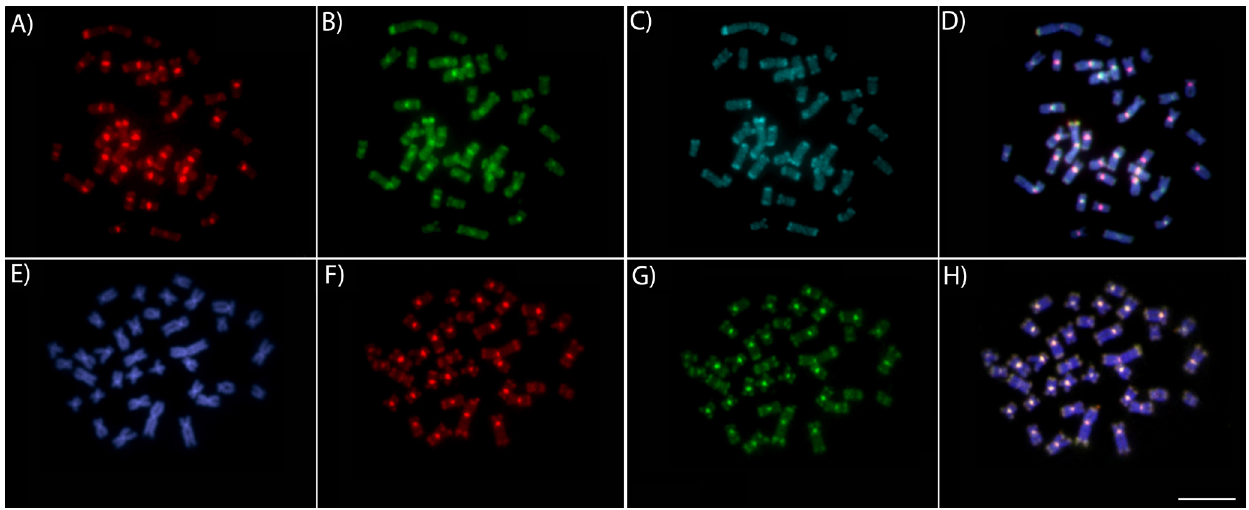
FIGURE 5 | First Row: Mitotic chromosome spreads of Lebiasina minuta males after CGH— interspecific comparisons ( A – D ). Male-derived genomic probe of L. minuta ( A ); L. melanoguttata ( B ); L. bimaculata ( C ) hybridized against male metaphase plates of L. minuta ( D ). Second Row: Mitotic chromosome spreads of Lebiasina minuta males after CGH— intraspecific comparisons ( E – H ). DAPI image ( E ); Male-derived genomic probe of L. minuta ( F ); Female-derived genomic probe of L. minuta ( G ) hybridized against male metaphase plates of L. minuta ( H ). The common genomic regions of both compared karyomorphs are depicted in yellow. Scale bar = 5